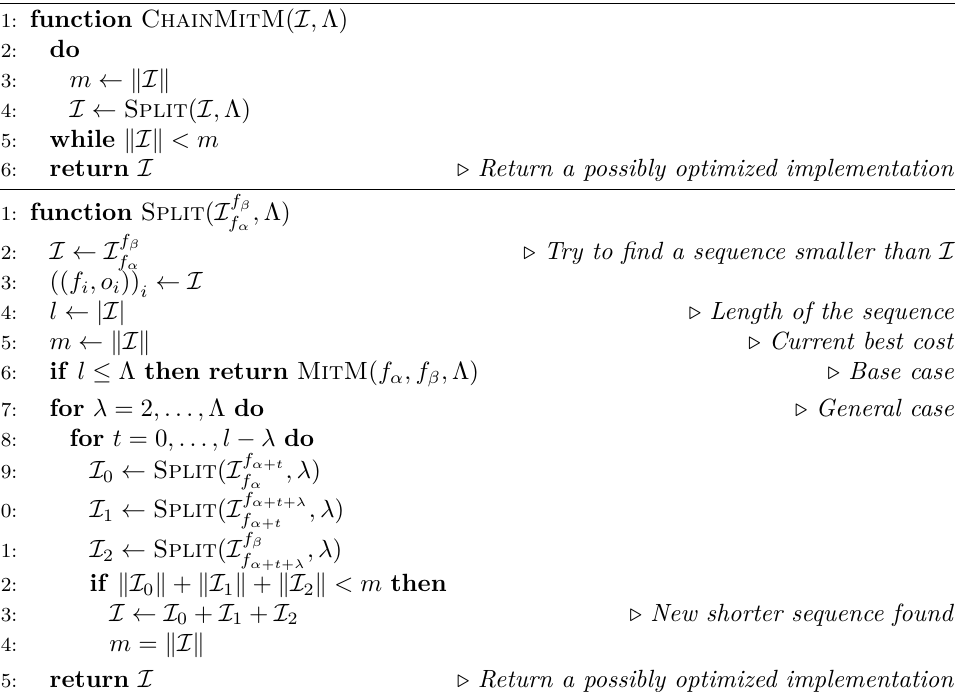
Algorithm 2 – Improve Heuristic Implementation.